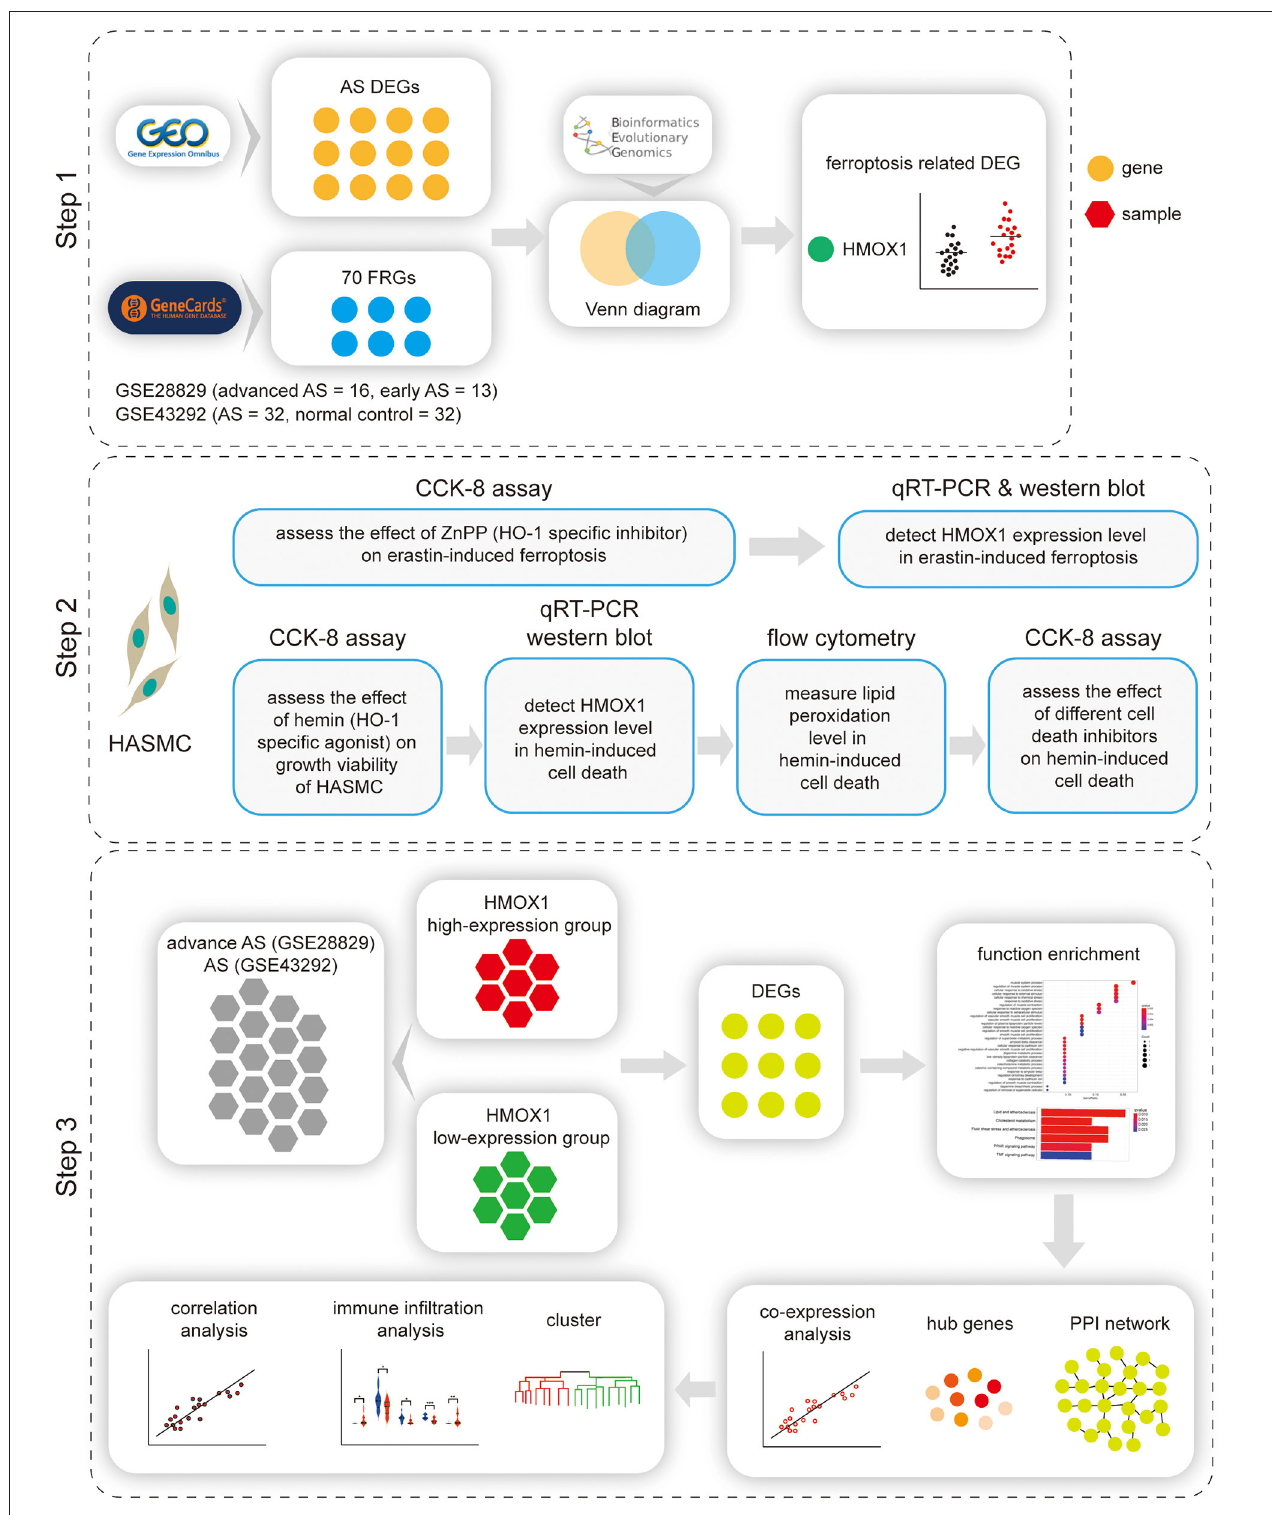
FIGURE 1 | Flow chart of the study. Step 1: Identification of HMOX1 as the ferroptosis-related DEG in atherosclerosis. Step 2: Validating the pro-ferroptotic effect of HMOX1 in HASMCs. Step 3: Single-gene analysis of HMOX1. DEG, differentially expressed gene; HASMC, human aortic smooth muscle cell; AS, atherosclerosis.